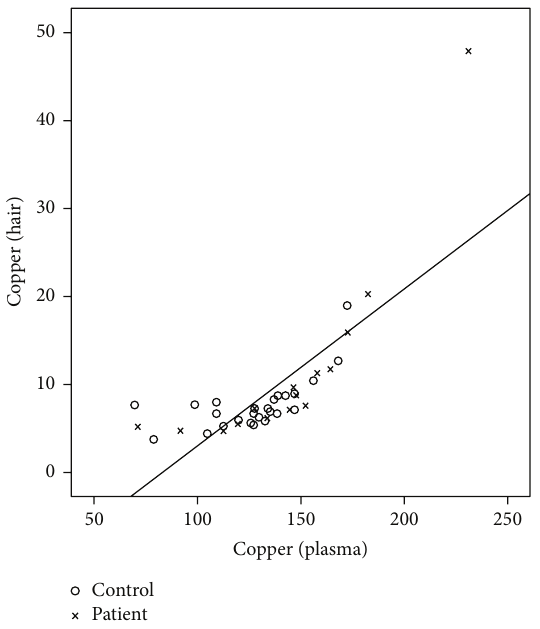
Figure 3: Correlation between plasma and hair copper level in patients and